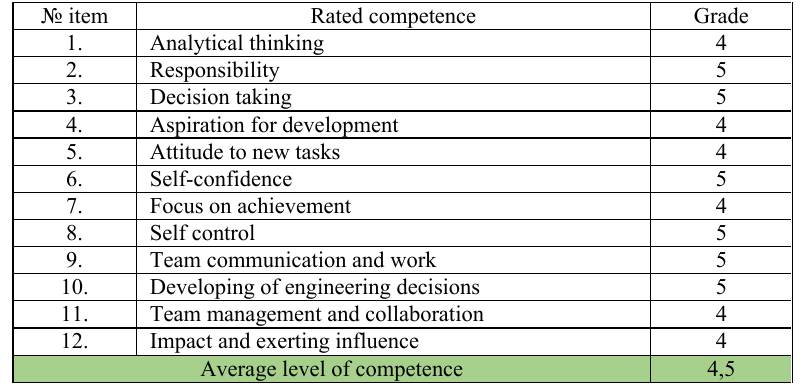
Fig. 2. Competence level of an employee found as a result of assessment according to «Compagement»